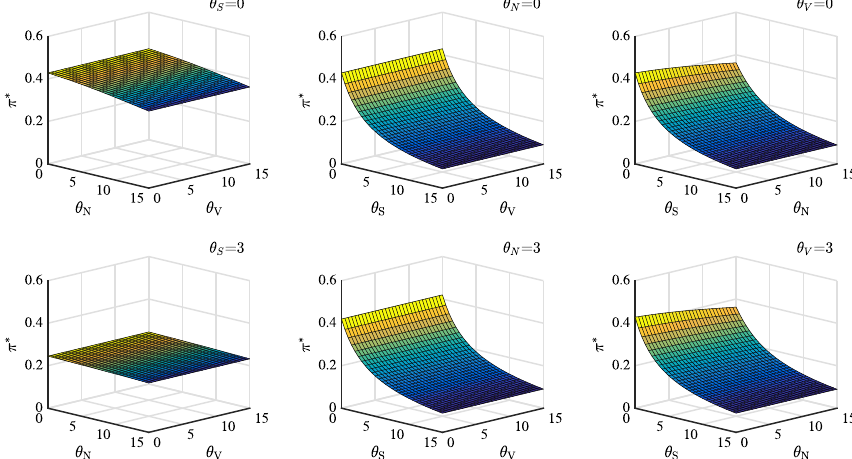
Fig. 7 Optimal portfolio choice in Bitcoin market as a function of ambiguity aversion parameters θ S , θ V and θ N . Panel ( a ), ( b ) and ( c ) set θ S , θ N and θ V as 0, respectively. By contrast, Panel ( d ), ( e ) and ( f ) set θ S , θ N and θ V as 3, respectively